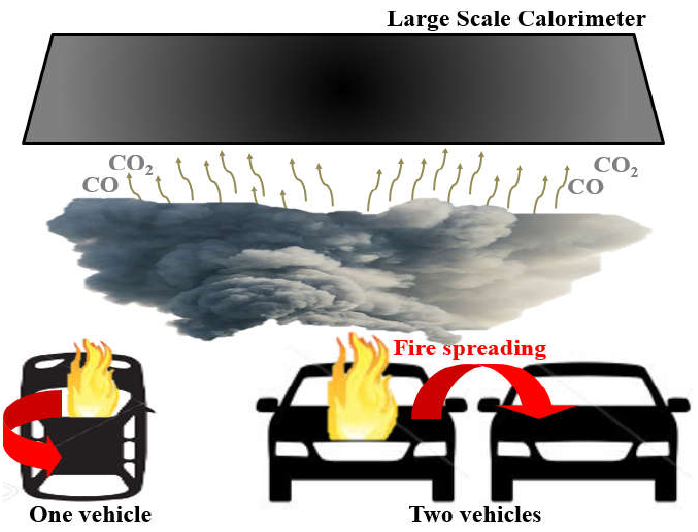
Figure 1. Schematic diagram of the basic concept for this